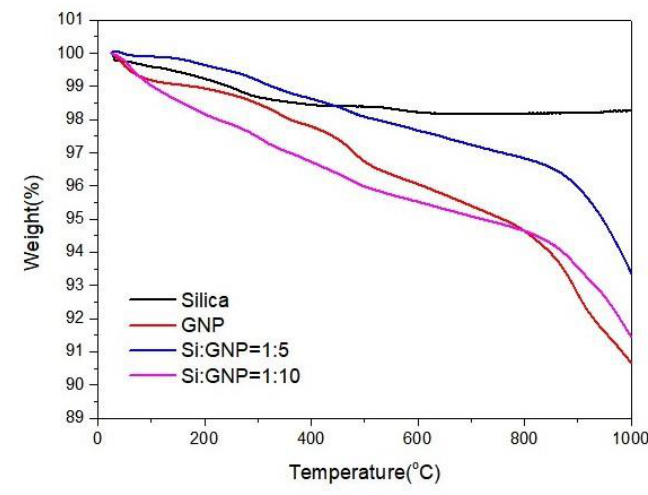
Figure 7. TGA curves of silica, GNP, Si:GNP = 1:5 and Si:GNP = 1:10 hybrid materials. Figure 8a represents Raman spectra of silica, GNP and hybrid additives of Si:GNP = 1:5 and